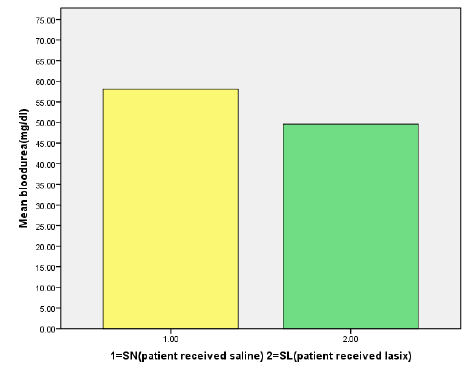
Figure (3): shocked patients received 2ml normal saline group versus shocked patients received 2 ml Furosemide group in sense of weight, there is no significant statistical difference (p=0.121).